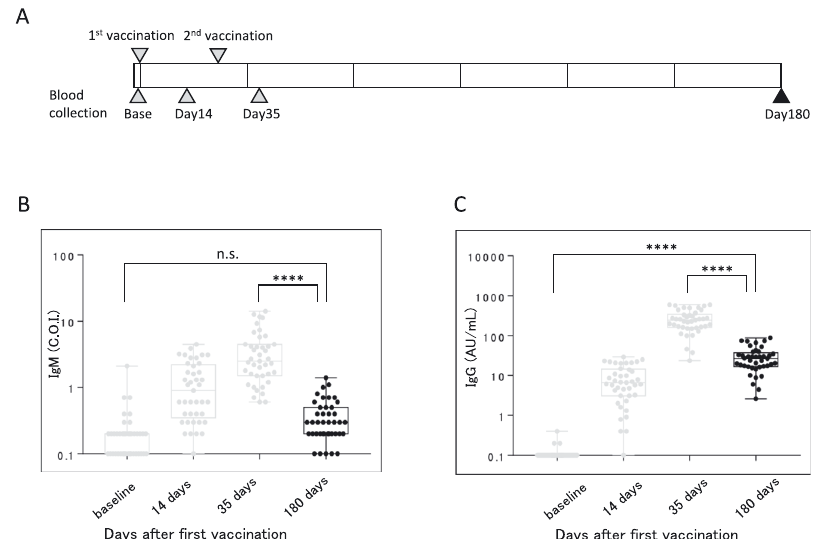
Figure 1: Sampling and vaccination